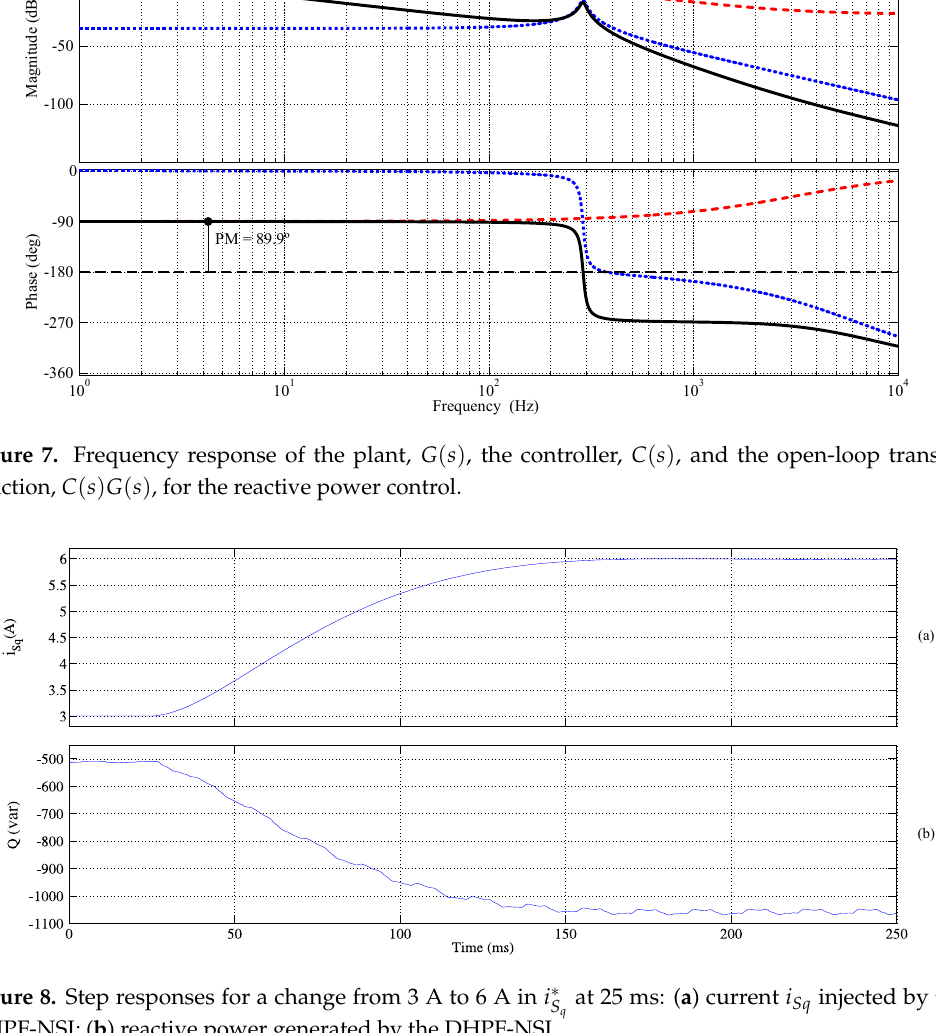
at 25 ms: ( a ) current i Sq injected by the S q